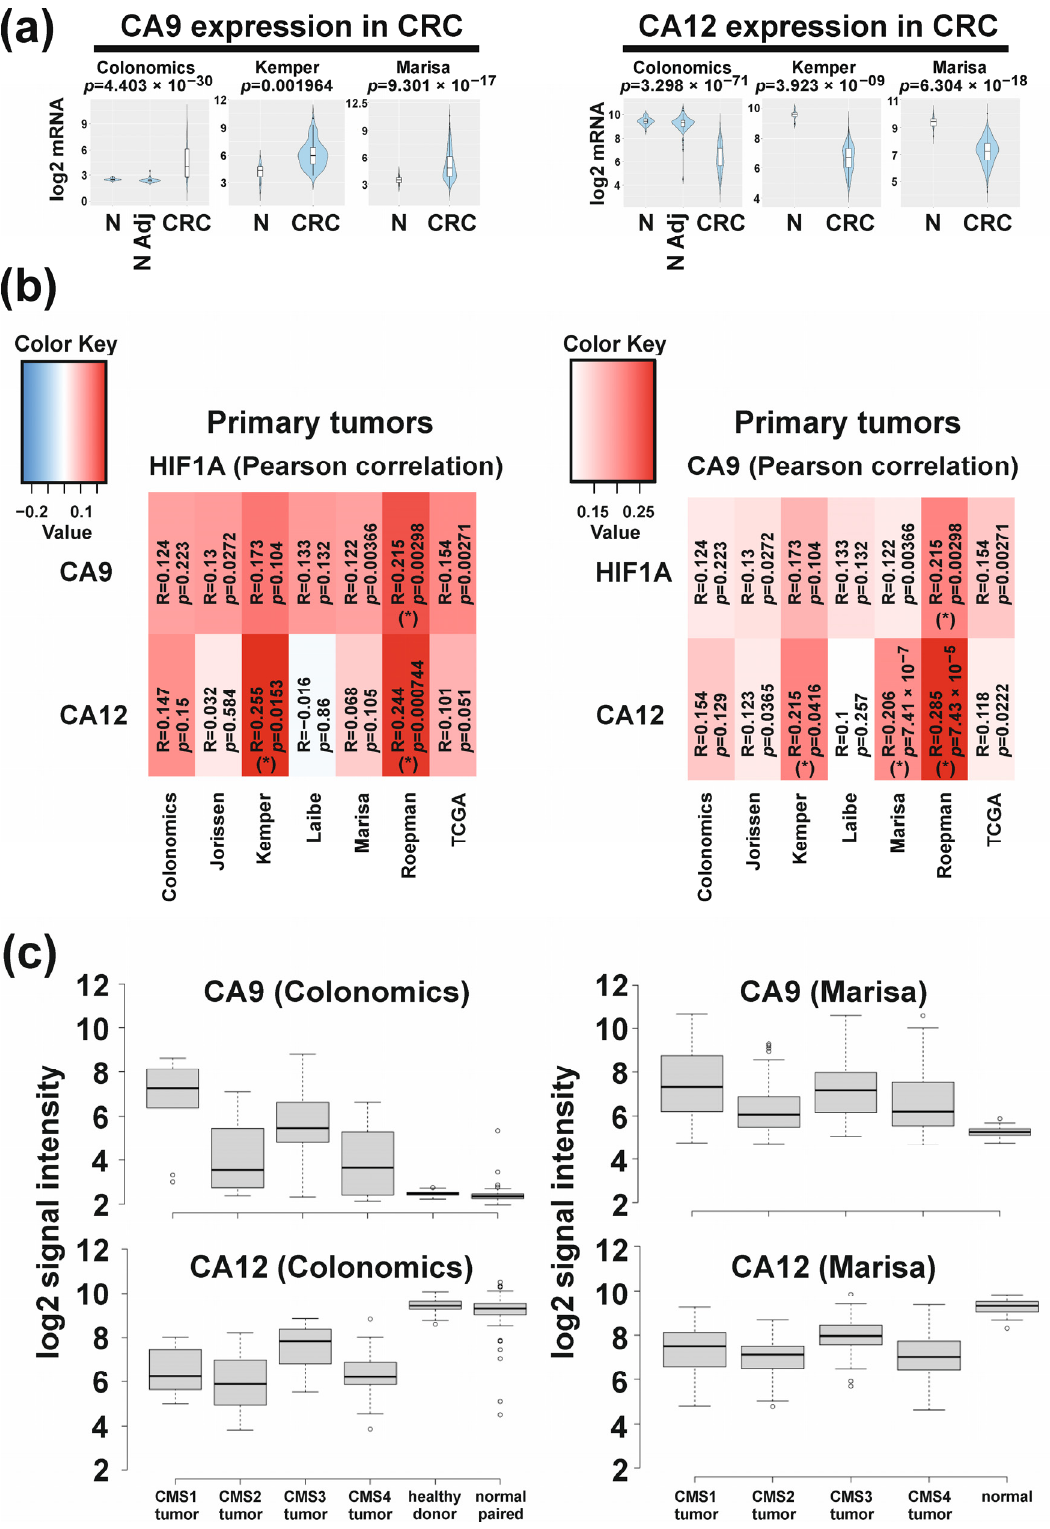
Figure 1. Analyses of expression and correlation of CA9, CA12 and HIF1 α on transcriptomic levels in patient tumor samples using Cancertool [60]. ( a ): Expression of CA9 and CA12 in relation to normal or normal-adjacent tissue in 3 out of 7 CRC datasets. Other 4 datasets did not contain normal tissue and could, therefore, not be included for this analysis. (N = normal tissue; N Adj = normal tissue adjacent to tumor; CRC = colorectal carcinoma) ( b ): Heat maps of correlation analyses based on HIF1 α (left) and CA9 (right) in 7 datasets showing overall positive correlation of both CAs to HIF1 α and both CAs to each other with different stringency depending on datasets. ( c ): CMS-related